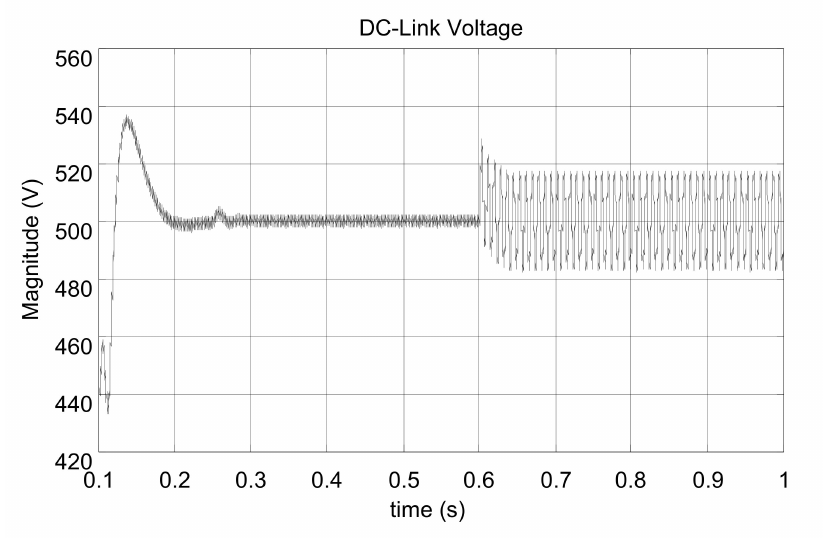
Figure 19. DC-link capacitor voltage via the conventional